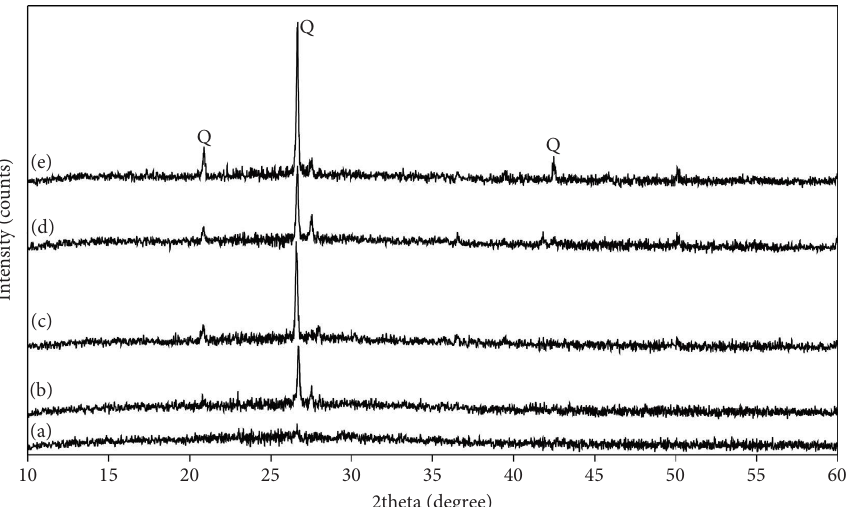
Figure 7: XRD patterns of a 28-day-cured AAFA: (a) FA-100RG, (b) FA-75RG, (c) FA-50RG, (d) FA-25RG, and (e) FA-0RG (Q � quartz (SiO